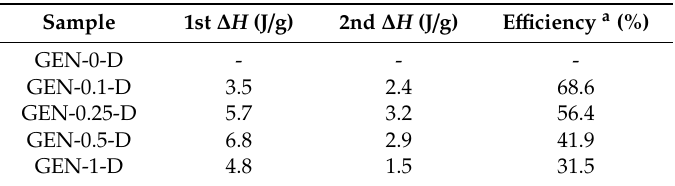
Table 2. Enthalpy changes in the GEN-X-D composites.